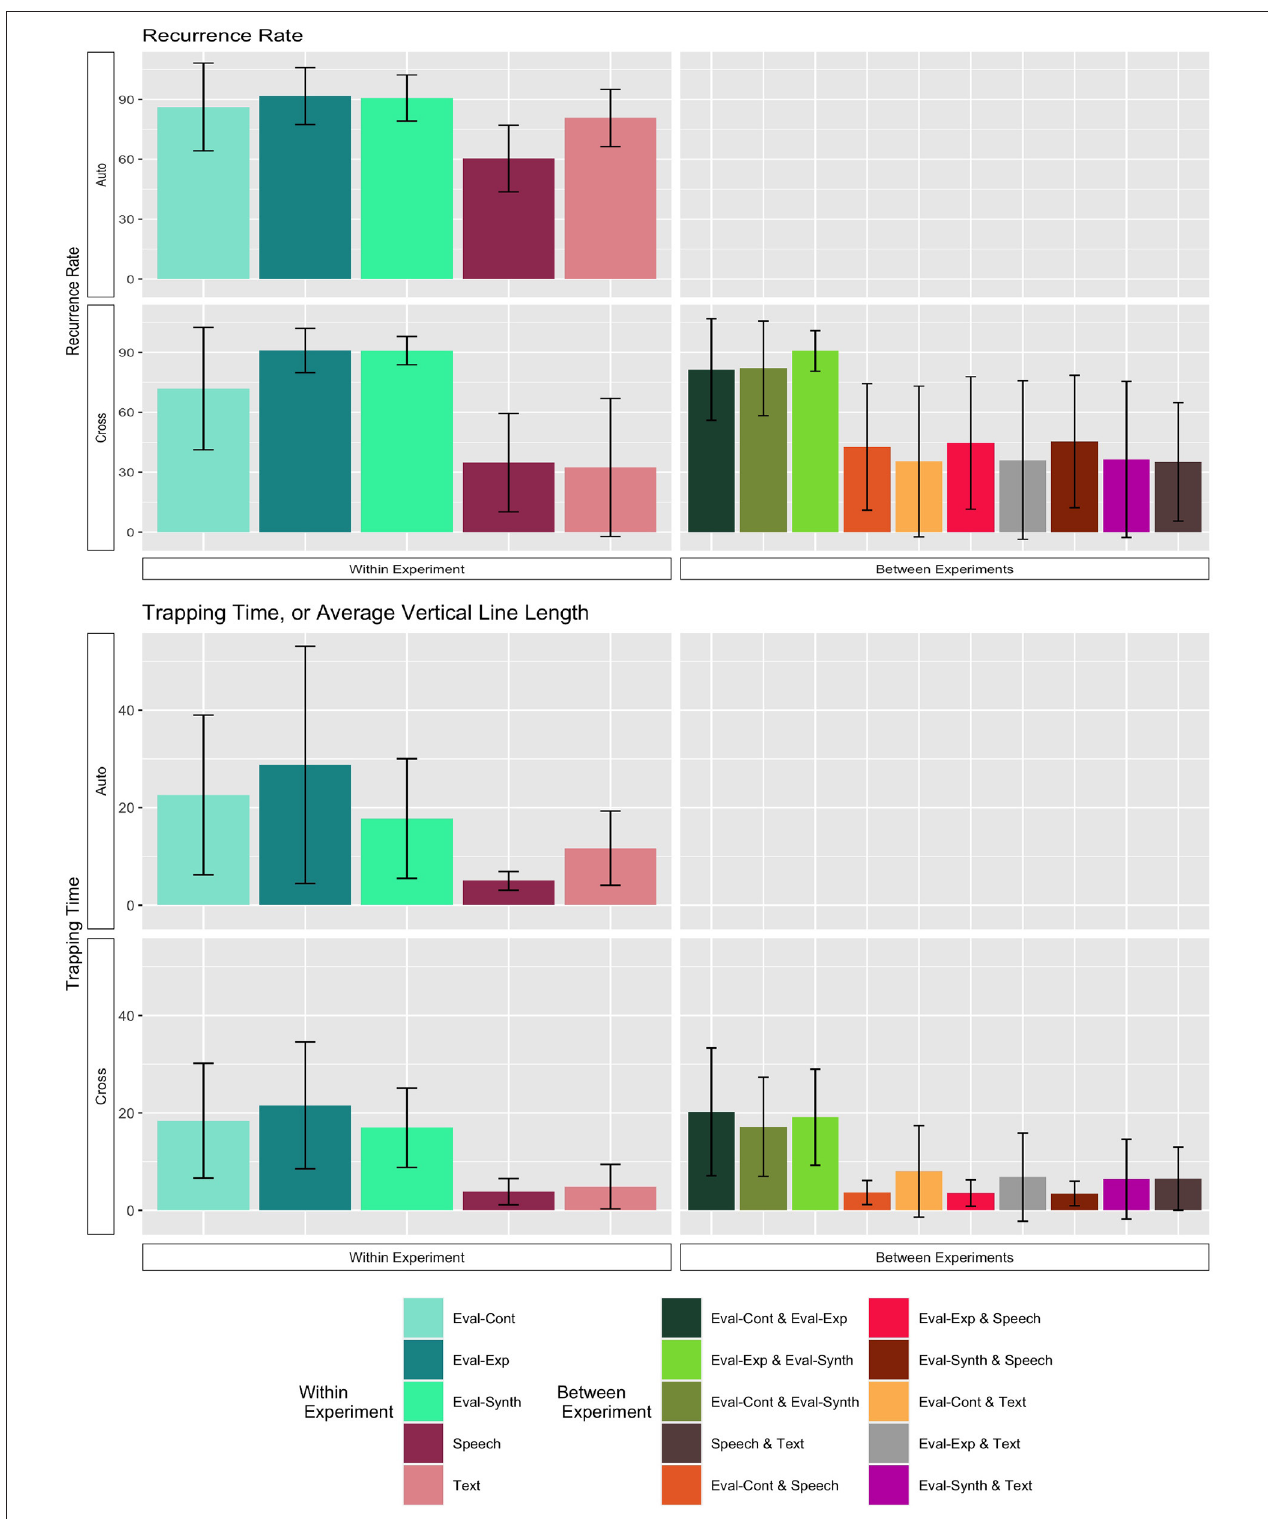
FIGURE 7 | Recurrence rate and trapping time statistics for RQA. The upper plots give the Auto-RQA statistics, and the bottom rows give the Cross-RQA, split by within (left) and between (right) Experiment conditions. Bars give the mean statistics; error bars are ± 1 standard deviation of the mean.